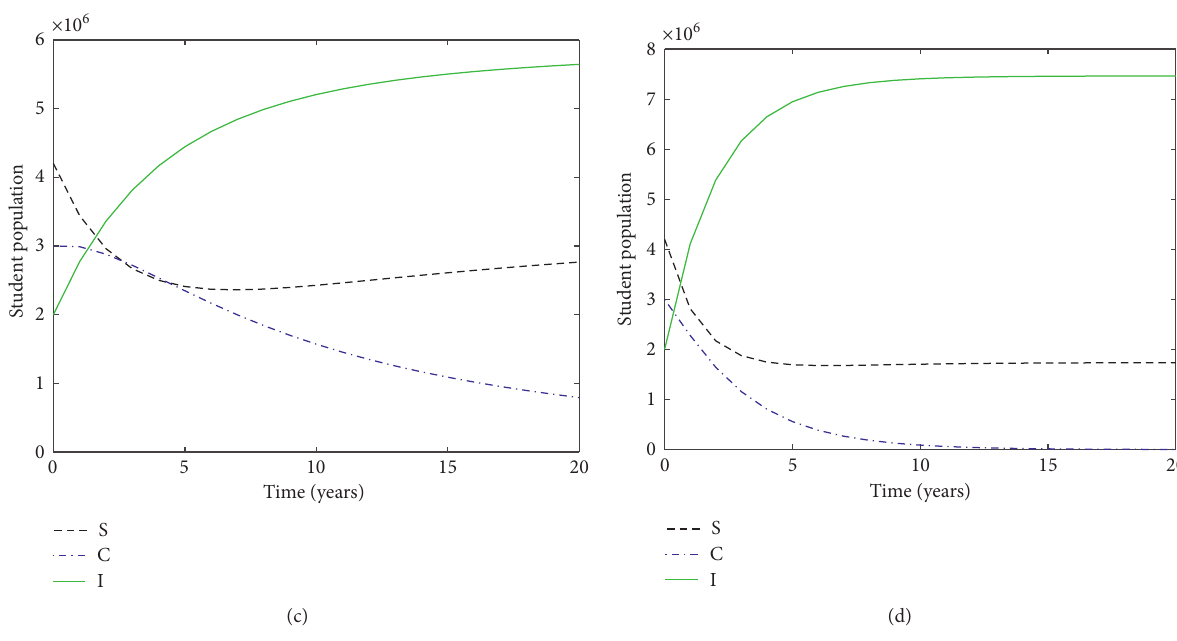
Figure 5: Simulation of the model showing the total number of Susceptible, Morally corrupt, and Immune as a function of time using initial conditions given in Section 2. Parameters used are in Table 2 with (a) σ � 0, α � 0, R � 1 . 359; (d) σ � 0 . 20, α � 0 . 15, R (c) σ � 0 . 05, α � 0 . 05, R 0